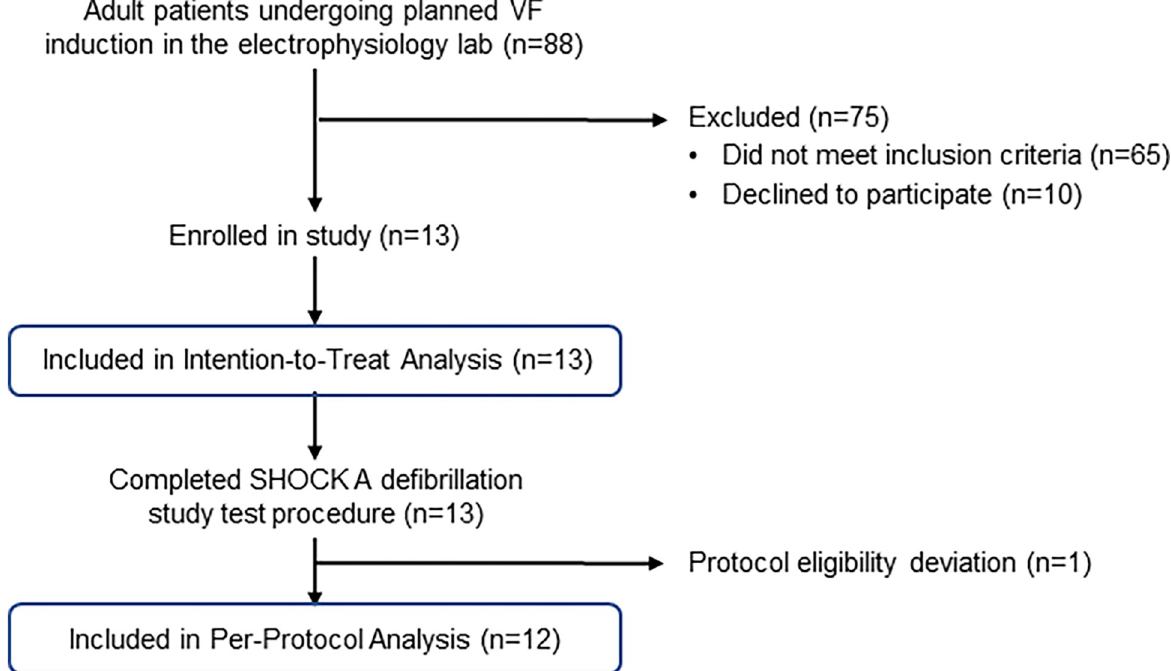
Fig 12. Human study consort flowchart. Of the 88 patients assessed for eligibility, 13 met inclusion criteria and consented to enroll in the study. Defibrillation study procedure was completed on all 13 enrolled patients and included in the Intention-to-Treat analysis. Study monitoring identified that an enrolled patient had been prescribed Amiodarone during an emergency room visit (three weeks prior to study enrollment) and continued taking it for 6 days (protocol eligibility deviation). Twelve patients were included in the Per-Protocol analysis.